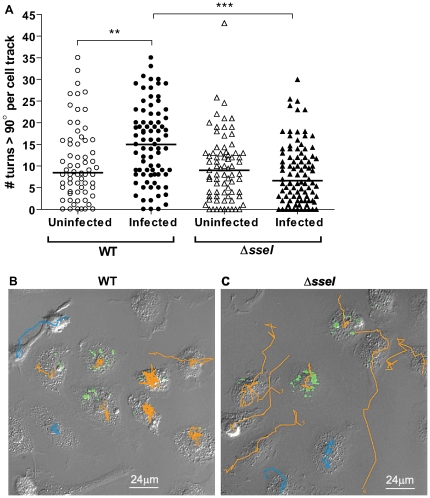
SseI causes S. typhimurium-infected BMDM to reverse their direction of travel more frequently.A) BMDM were seeded onto two-chamber glass slides and infected with GFP-expressing strains of WT (WT(pFPV25.1)) or ΔsseI (ΔsseI(pFPV25.1)) S. typhimurium for 24h. Four locations from each chamber were imaged by time-lapse microscopy (DIC and fluorescence; images were taken every 3min; 45 images were taken in all per movie). The number of times a cell changed its direction of movement more than 90° (per video) are reported for infected cells and their uninfected neighbors (bars represent the median, the data are compiled from 28 total movies (14 movies per bacterial strain) performed in 4 independent experiments, n = 66 for uninfected cells (circles) and n = 82 for infected cells for WT S. typhimurium-infected BMDM (filled circles), n = 75 for uninfected cells (triangles) and n = 96 for infected cells for ΔsseI S. typhimurium-infected BMDM (filled triangles)). **, p-value<0.01 and ***, p-value<0.001; Mann-Whitney U test. B–C) The frames and cell-tracks of two representative movies are shown (B, WT; C, ΔsseI, tracks of uninfected cells are shown in blue and those of infected cells are orange), and the full videos are available online (Videos S1 and S2).